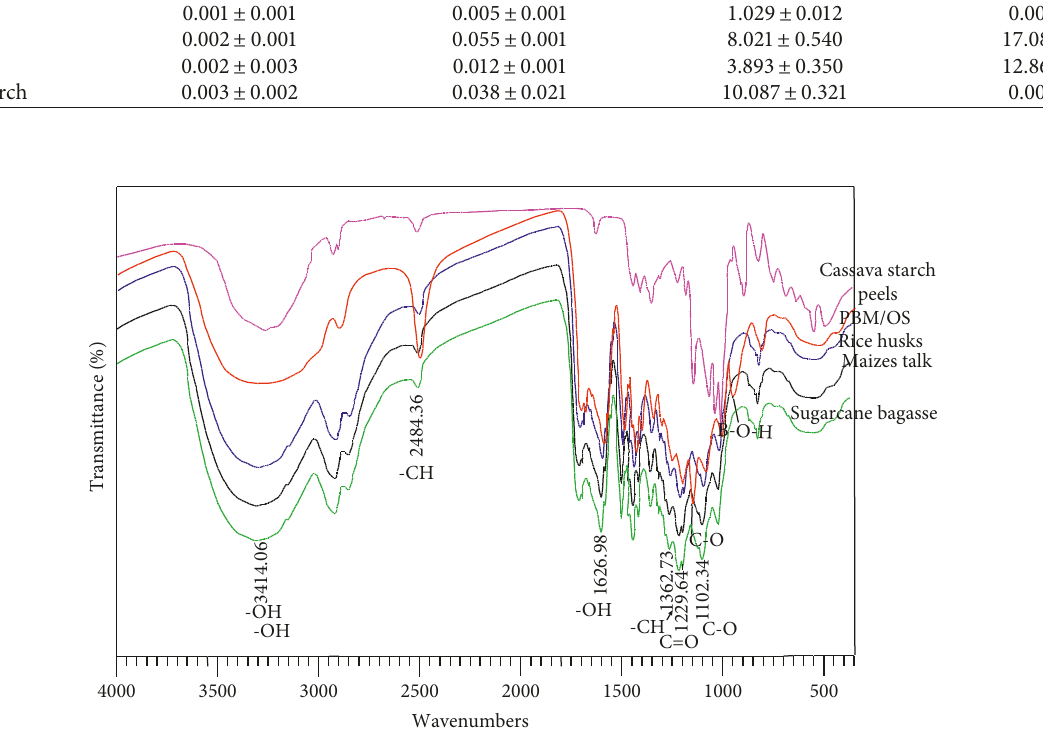
Figure 6: FTIR spectra for cassava starch, rice husks, sugarcane bagasse, and PBM/OS board.